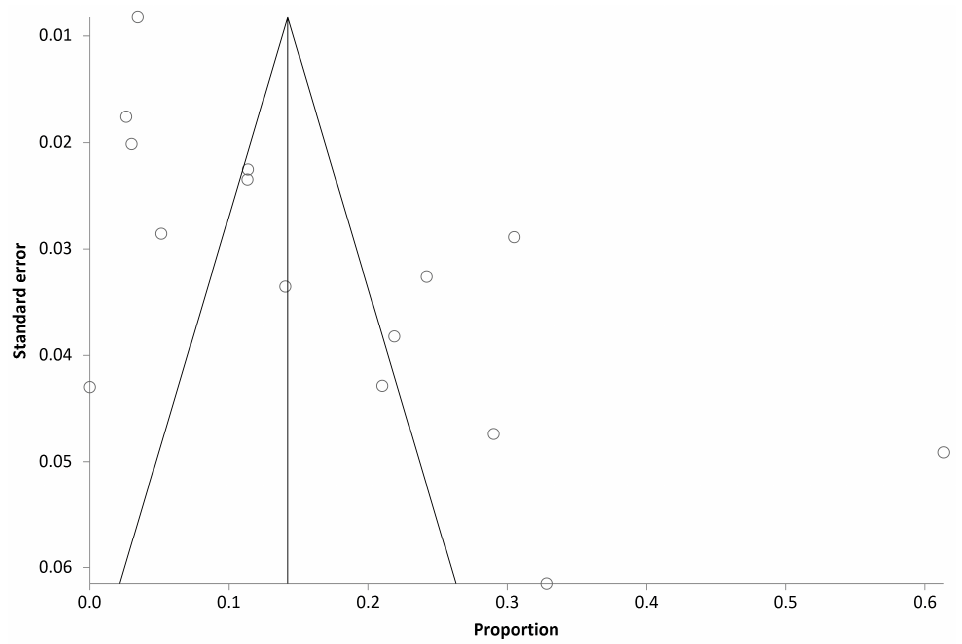
Figure 3. Funnel plot showing significant publication bias for the outcome of aspergillus sensitization in children with bronchial asthma. The proportion and standard error are displayed along the horizontal and vertical axes, respectively.